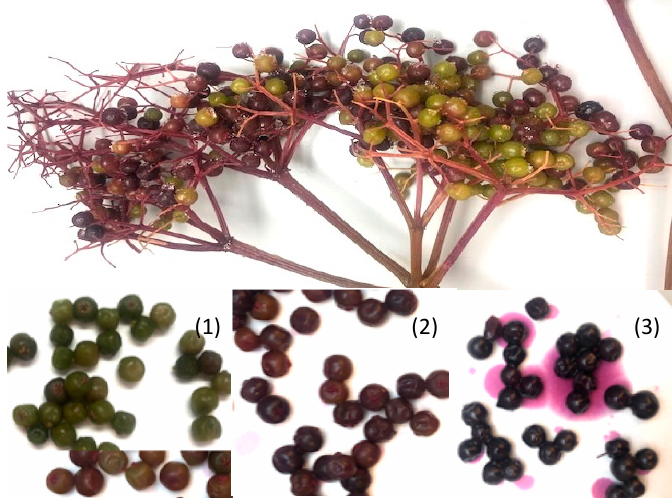
Figure 4. American elderberry fruits on the same branch at (1) Immature, (2) Half-ripe, and (3) Fully- Figure 4. Americanelderberryfruitsonthesamebranchat( 1 )Immature,( 2 )Half-ripe,and( 3 ripe stages.